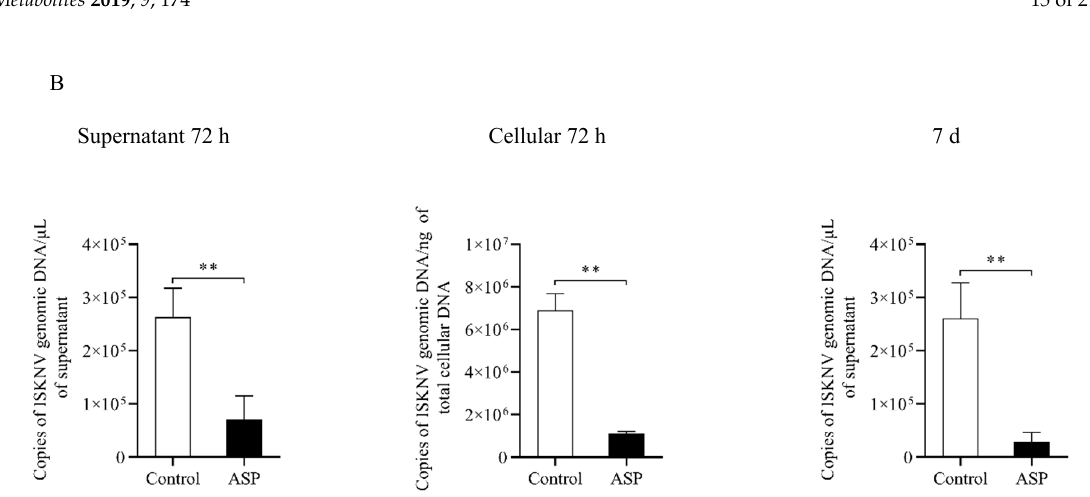
Figure 8. Aspartate inhibits the yield of ISKNV in CPB cells. ( A ) CPE of ISKNV-infected CPB cells